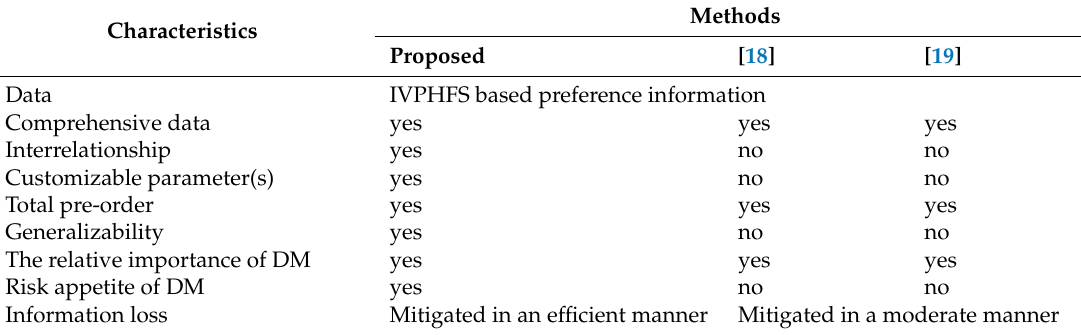
Figure 5. Corrplot for different ranking methods: Proposed vs. Others. Table 7. Characteristics analysis for proposed vs. other methods.